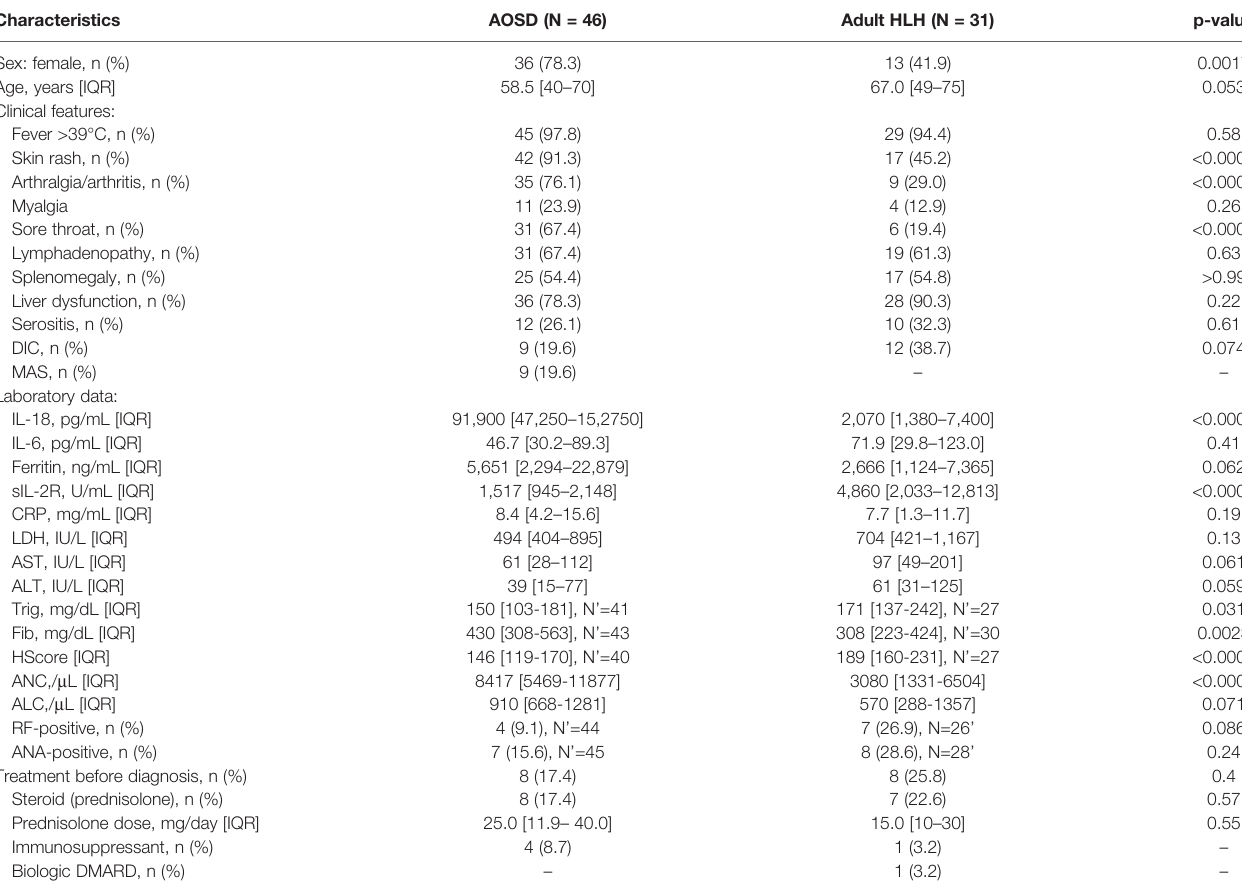
TABLE 1 | The demographic, clinical and laboratory characteristics of the AOSD and adult HLH group.